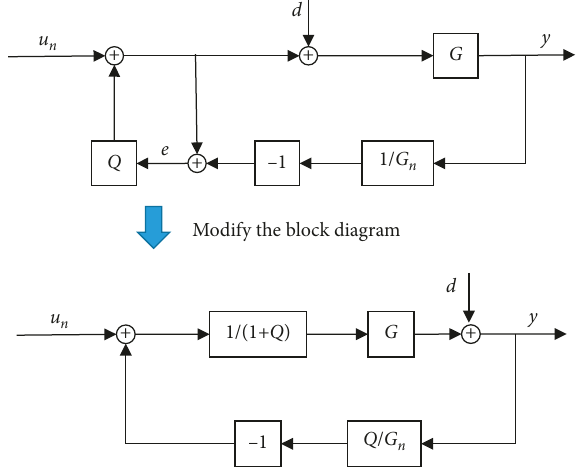
Figure 11: The architecture of the disturbance